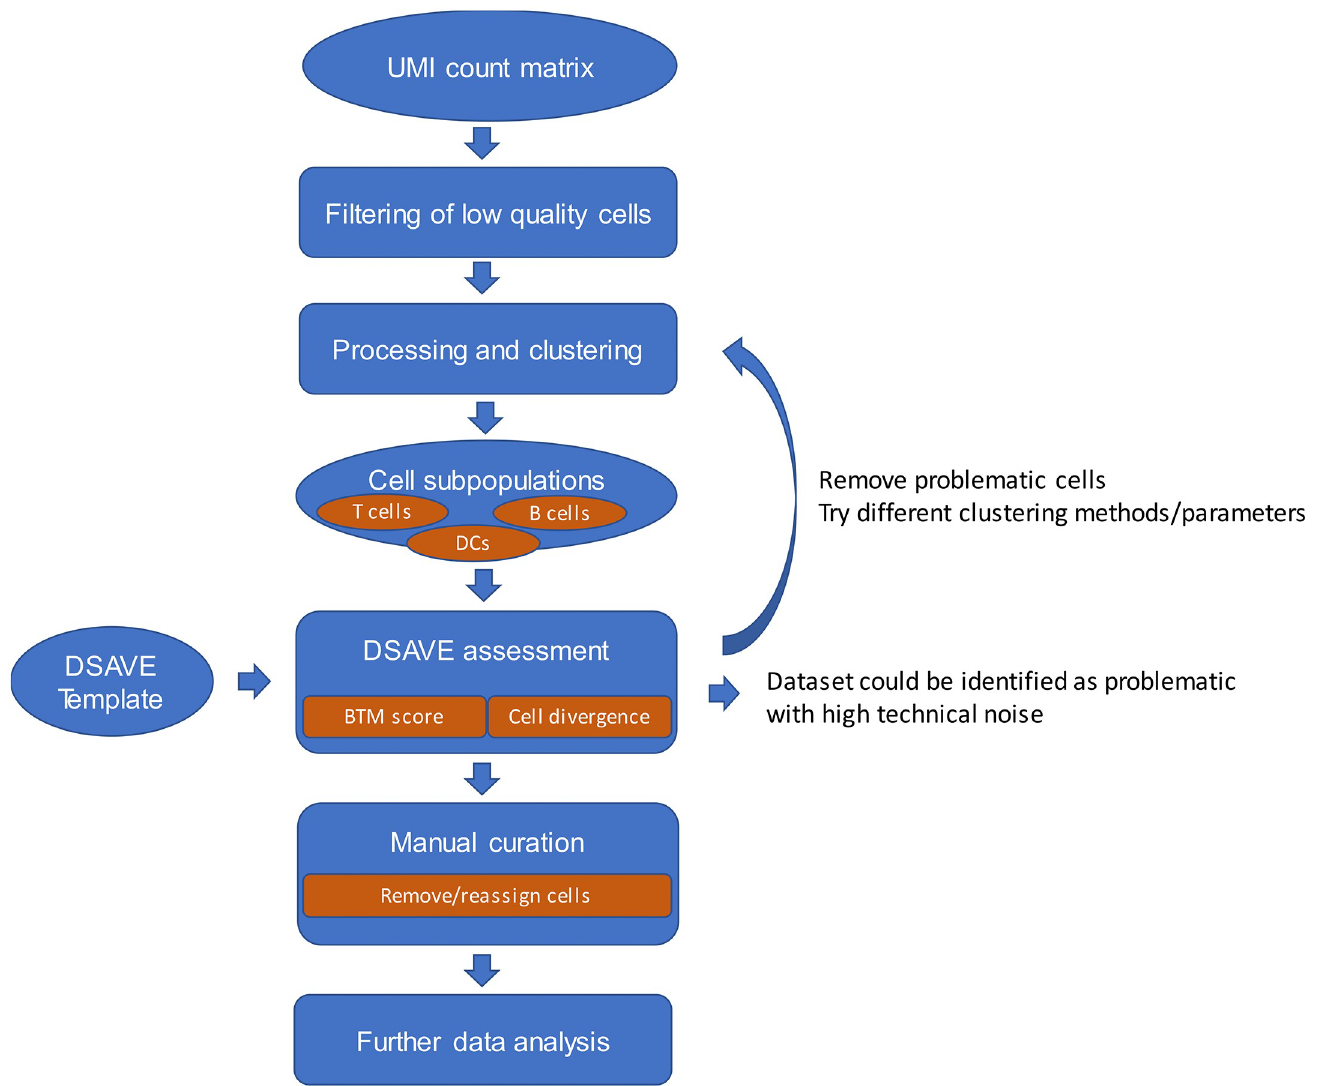
Fig 1. Typical use case for the DSAVE BTM variation score and DSAVE cell divergence. Ovals represent data while rounded rectangles represent data processing. The DSAVE BTM variation score and cell divergence are both applied to cell populations defined by clustering, using the original UMI count data in combination with cell clustering assignments. DSAVE allows for an iterative approach where the user can remove/reassign cells, experiment with clustering parameters, and assess the outcome, both in terms of total cell variation within the cluster (the BTM variation score) and detected misclassified cells. When the results are satisfactory the user can finalize the curation and proceed to further data analysis. The BTM variation score calculation requires a DSAVE template, which is explained further below in the methods